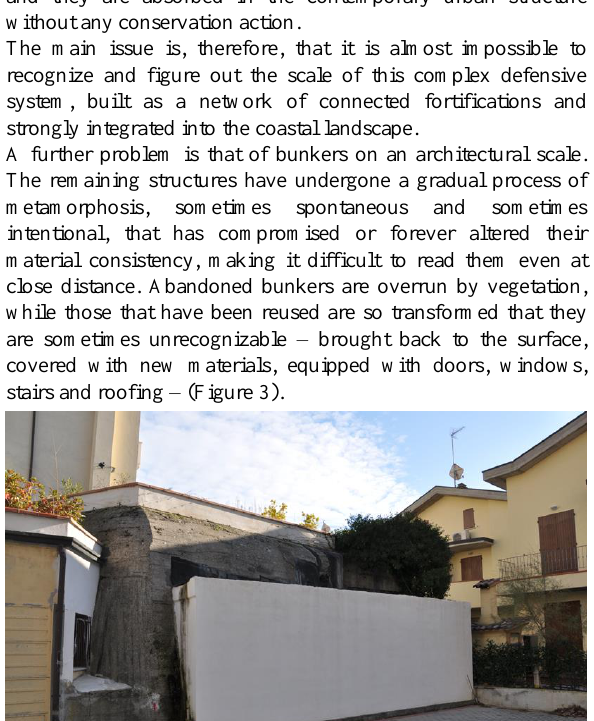
Figure 2. Tobruk , Plans and sections. National Archives of the Netherlands, Le-Hague, Bunkerarchief, 2.13.167, inv. nr. 1038, public domain. Figure 3. Lido di Savio (RA), Example of a bunker embedded in contemporary buildings. © Zampini,